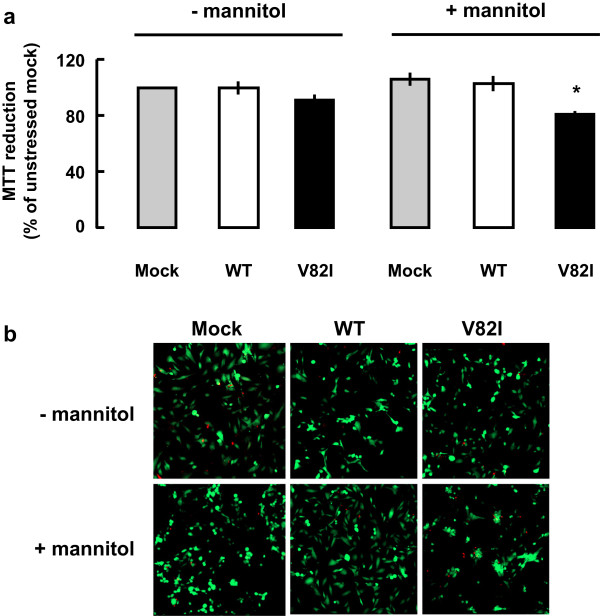
Effects of Cav-3 WT or Cav-3 V82I expression on cells viability. BHK cells were transiently transfected with Cav-3 WT or Cav-3 V82I and mitochondrial activity and cell death were evaluated by MTT and Propidie/Fluorosceine assays, respectively. (a) Expression of Cav-3 WT or Cav-3 V82I did not modified mitochondrial function under basal conditions. On the contrary, a significant decrease of mitochondrial activity was observed in Cav-3 V82I expressing cells subjected to hyperosmotic stress. Data are representative of five independent experimental sessions. *, P < 0.05. (b) Images show the intravital staining that yields green yellow fluorescence for vital cells and red fluorescence for dead cells under basal and hyperosmolar conditions. Images are representative of three independent experiments.